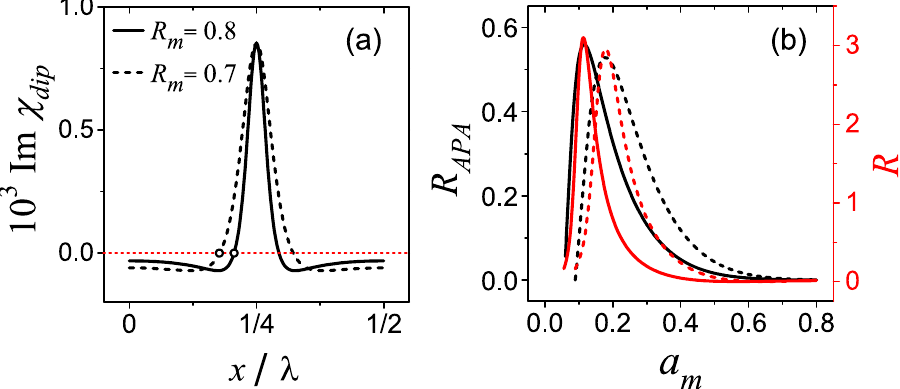
Figure 4. ( a ) The imaginary part of χ dip under different values of R m . The small circles indicate the positions of x 0 . The data is calculated using Eqs (9) and (12) with a m = 0.2; ( b ) Relation between reflectivity and the amplitude of control field. Different linecolors distinguish the reflectivity obtained from the two methods: Black lines indicate that the data is calculated using the APA approximation method, while the data represented by red lines is obtained from Eq. (16). Two kinds of lineshapes are used to differentiate values of R m : solid line for R m = 0.8, and dashed line for R m = 0.7. Other parameters are α = Γ 0 , Γ = 500 Γ 0 , γ t = Γ 0 , λ c = 1.083 μ m, L = 5 mm, and Δ =